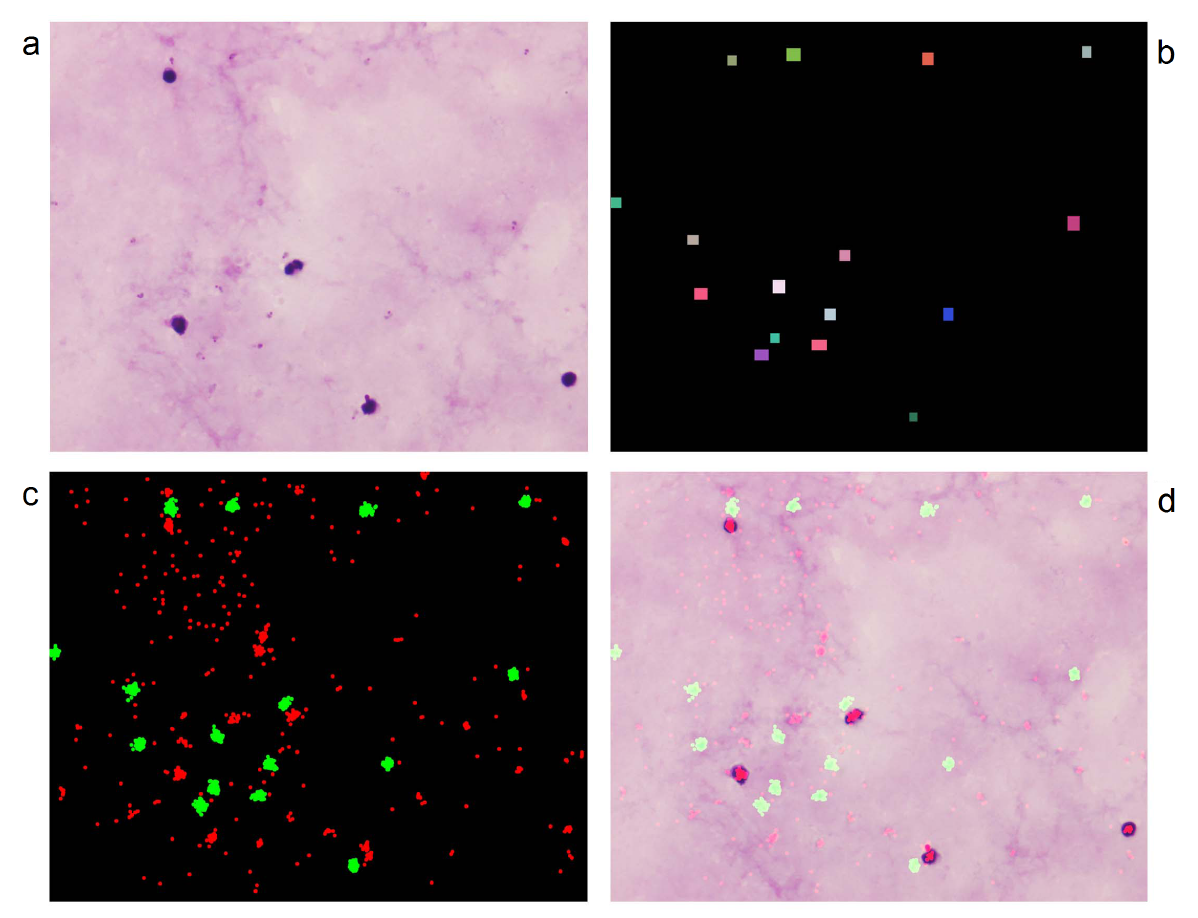
Figure 2. Crowdsourced image analysis of thick blood film infected with malaria. (a) Test image analyzed in the game. (b) Gold standard image in which each label corresponds to a parasite. (c) Aggregation of gamer’s clicks where green regions correspond to correctly tagged parasites and red regions to players’mistakes. (d) Gamers’clicks superimposed on raw